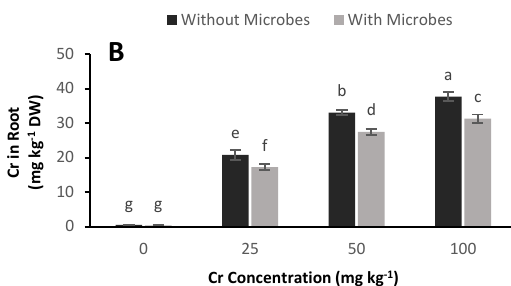
Figure 6. Influence of the di ff erent Cr levels (0, 25, 50, 100 mg · kg − 1 ), with and without peat-moss-based microbial inoculation, on Cr concentrations in shoots ( A ) and roots ( B ) of wheat plants. Bars indicate the mean values with standard SD of three replicates. Di ff erent bar letters show significant changes among various treatments at p < 0.05.